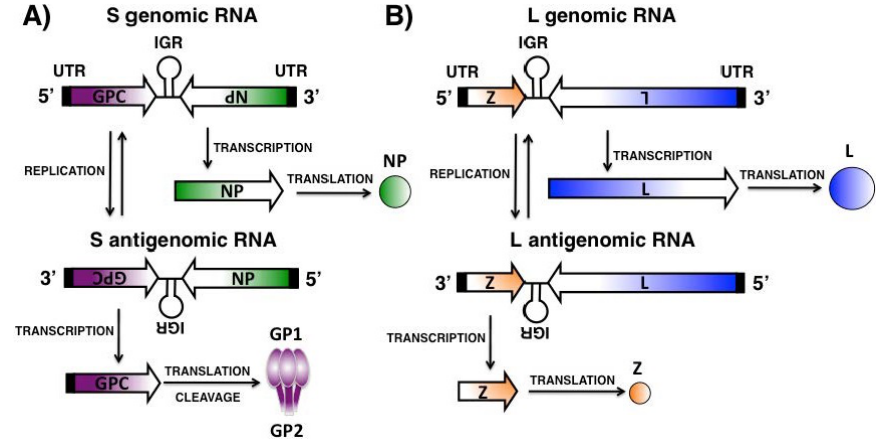
Figure 2. Arenavirus genome replication and gene transcription: The arenavirus replication cycle takes place entirely in the cytoplasm of infected cells. The L polymerase associated with the vRNPs initiates transcription from the viral promoter located within the untranslated region (UTR, black boxes) at the 3 1 termini of the vRNAs. Primary transcription results in the synthesis of NP ( A ) and L ( B ) mRNAs from the S and L segments, respectively. Transcription termination is mediated by a secondary stem-loop structure formed by the intergenic region (IGR) found in both vRNA segments between each of the two viral genes. Subsequently, the virus polymerase L adopts a replicase mode and moves across the IGR to generate a copy of the full-length antigenome S and L vRNAs. The antigenomic RNA S and L segments serve as templates for the synthesis of GPC ( A , S segment) and Z ( B , L segment) mRNAs. The antigenomic RNA S and L segments also serve as templates for the amplification of the corresponding viral RNA genome